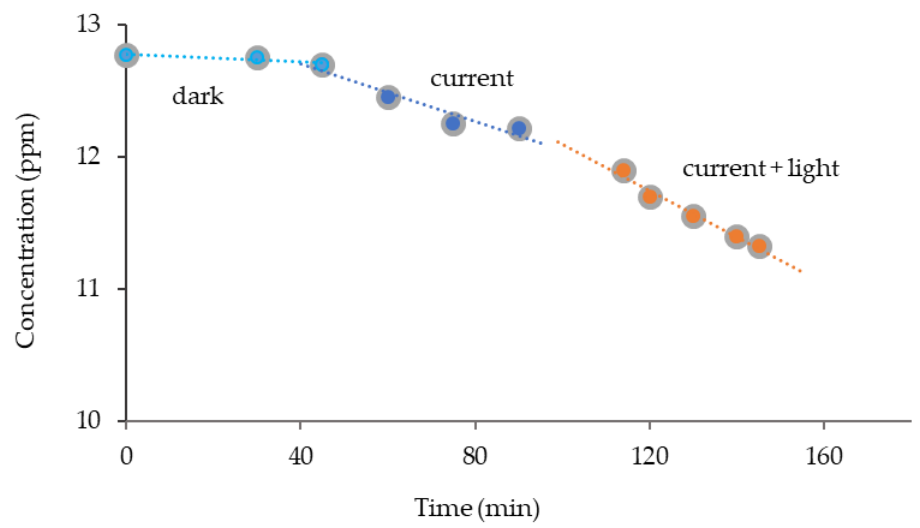
Figure 1. Trend of diuron (DRN) concentration during a preliminary run performed under different conditions: adsorption in the dark; galvanostatic electrolysis ( I = 1.25 mA) in the dark, and under irradiation.